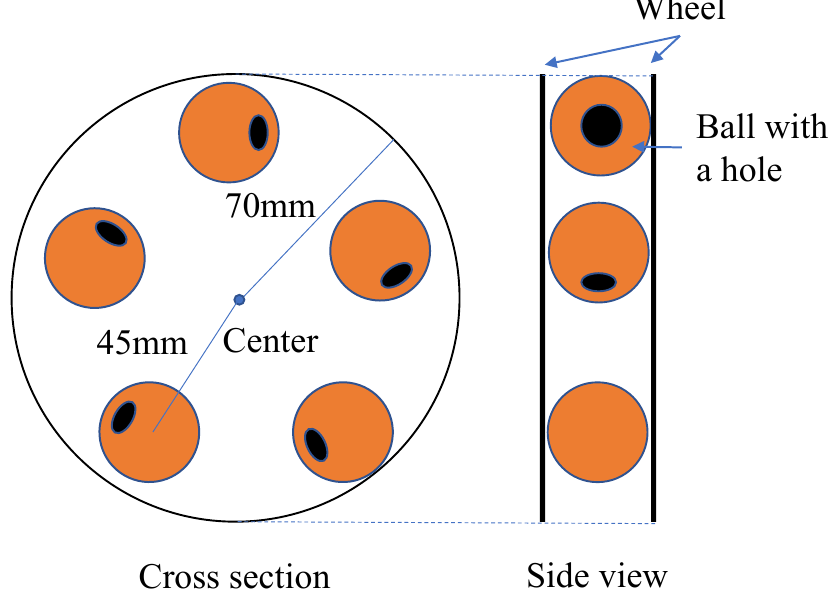
Figure 13. Design of an improved actuator (The diameter of the ball is 44 mm. The radius of the wheel is 70 mm. The ball was installed at a position 45 mm from the center of the wheel. Its weight is 25.8 g.).